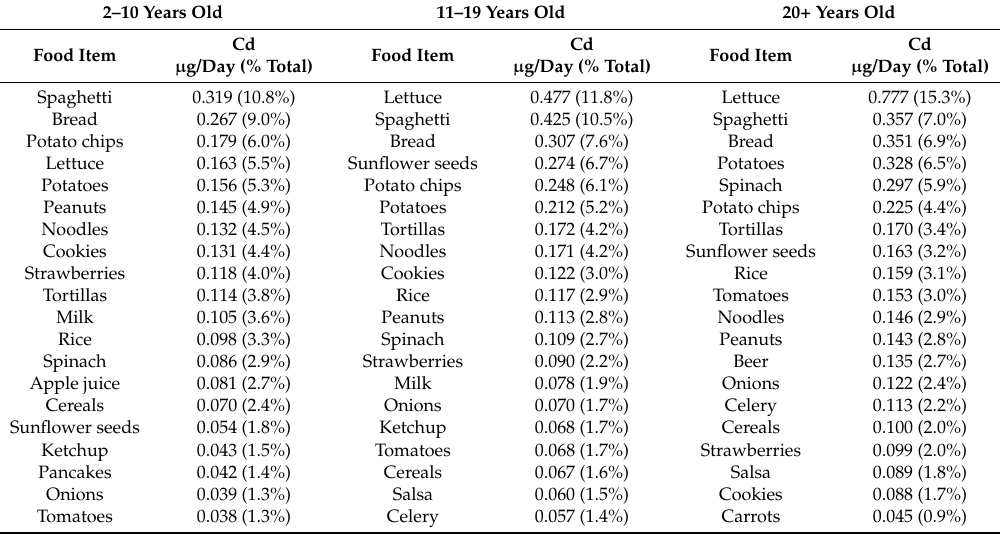
Figure 1. Cd contribution ( µ g/day/person) from major food groups among the US population aged ≥ 2 years in NHANES 2007–2012. Table 2. Top contributing food items to total Cd intake in the US population by age group in NHANES 2007–2012.